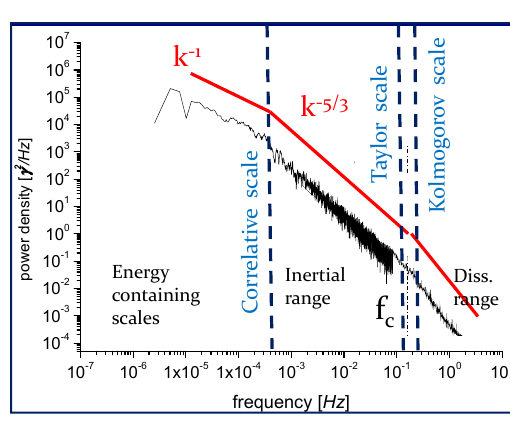
Figure 25: Typical interplanetary magnetic field power spectrum at 1 AU. The low frequency range refers to Helios 2 observations (adapted from Bruno et al. , 2009) while the high frequency refers to WIND observations (adapted from Leamon et al. , 1998). Vertical dashed lines indicate the correlative, Taylor and Kolmogorov length scales.